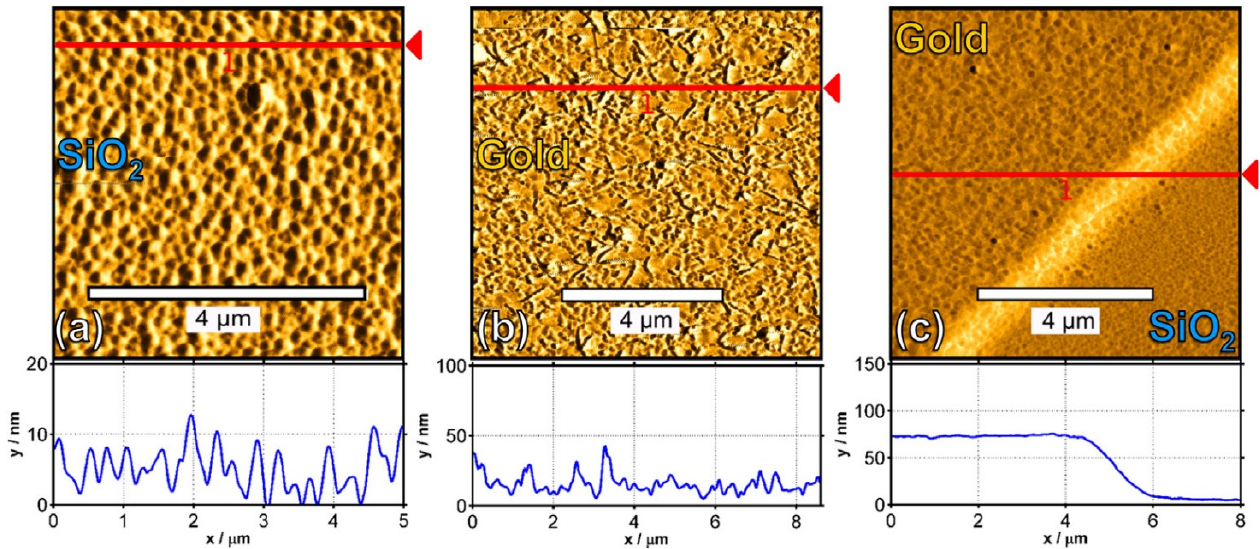
Figure 12. Pentacene deposition at 200 K: 1.5 monolayers on SiO 2 ( a ) and gold ( b ), plus 7.5 monolayers on the gold contact–channel transition region ( c ). The corresponding cross-sections are indicated in the AFM scans by a line and shown underneath correspondingly. Reprinted with permission from ref. [92]. 2015 Elsevier.